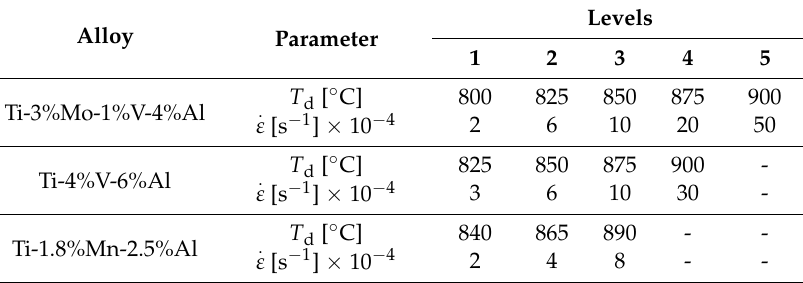
Table 3. Input levels of the investigated